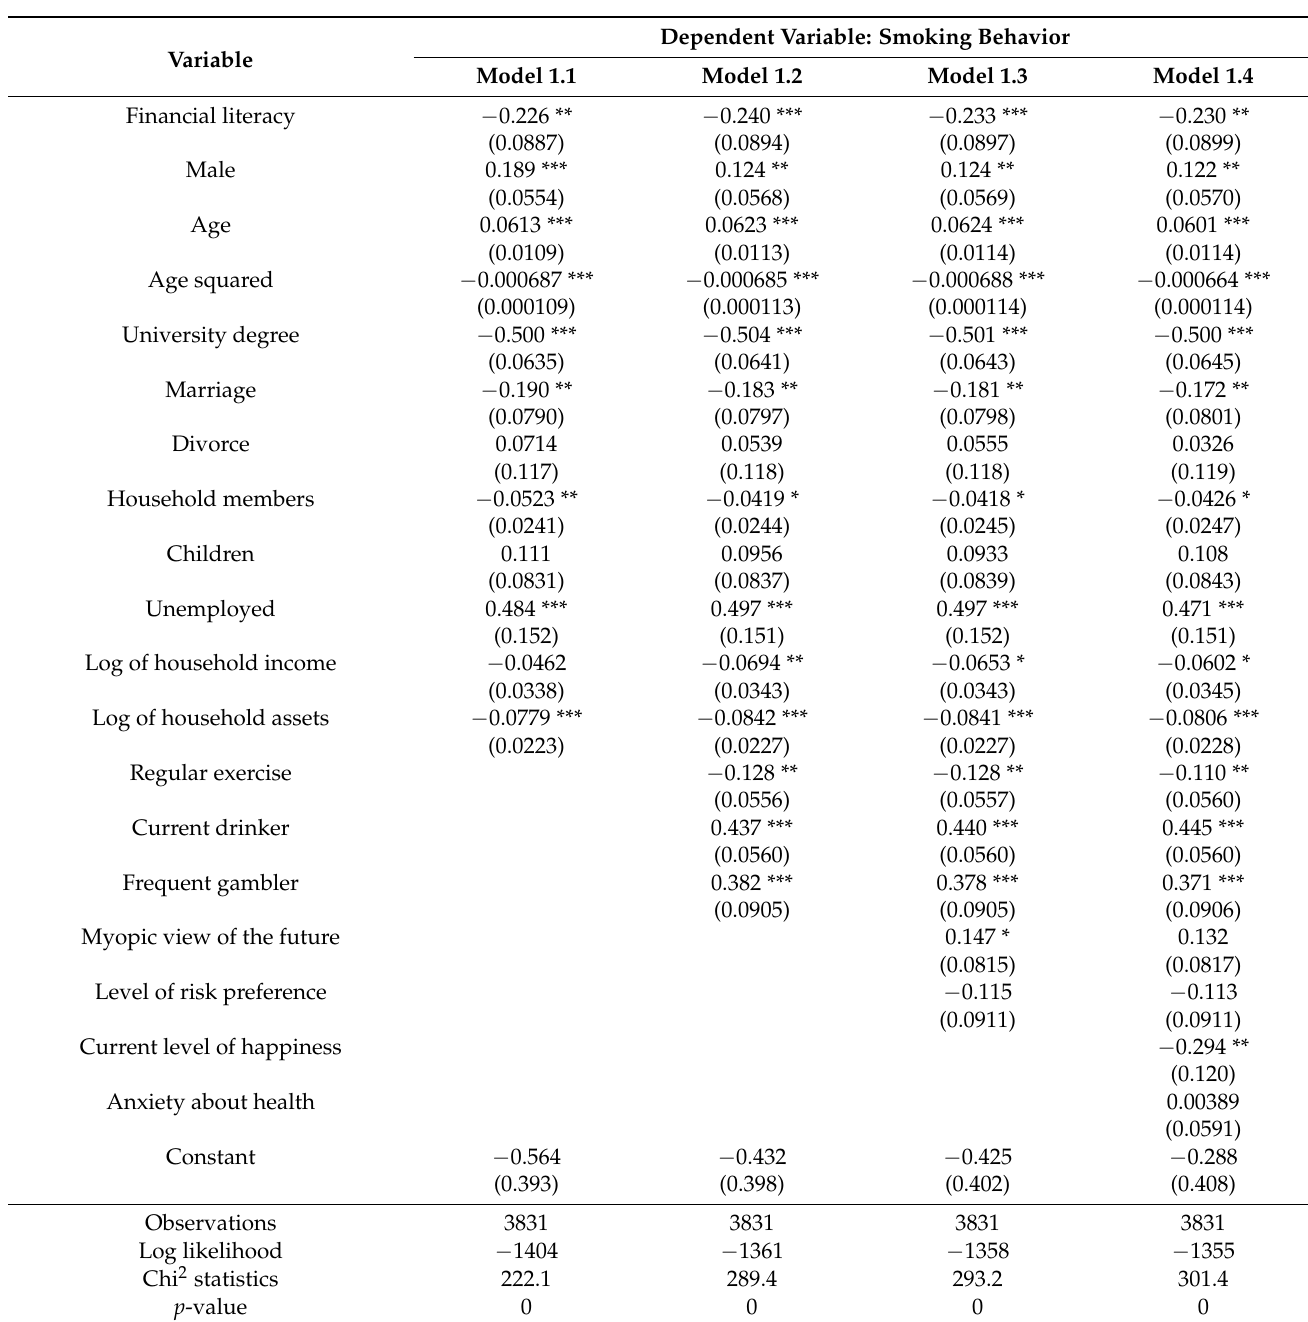
Table 6. Probit model regression results: financial literacy as the main explanatory